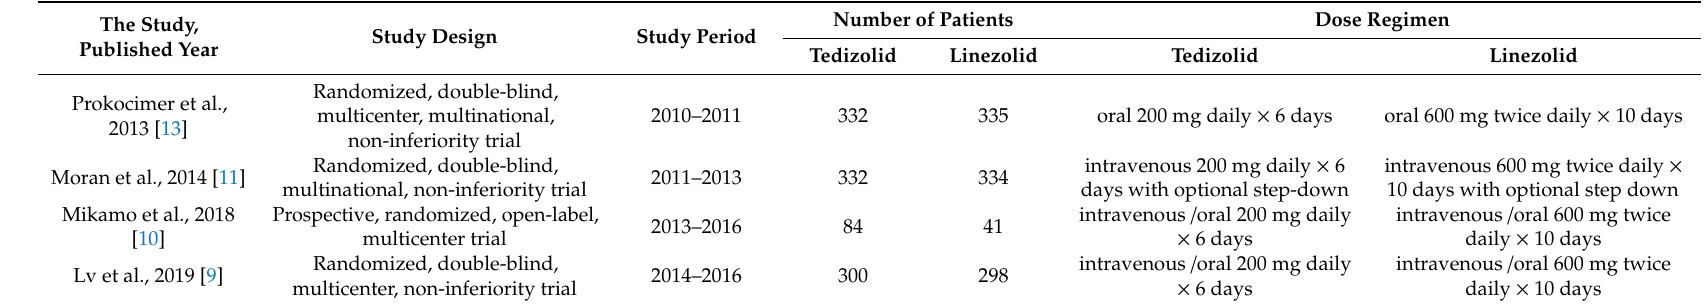
Table 1. Characteristics of included studies. MRSA = methicillin-resistant Staphylococcus aureus.